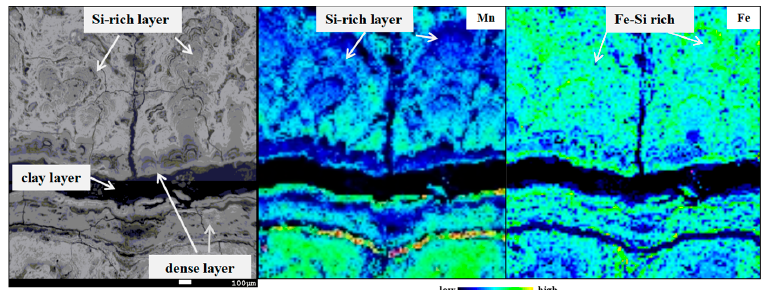
Figure 10. ( a , b ): Si and Mn+Si versus Fe; ( c ): In Si-rich layers Cu > Ni.